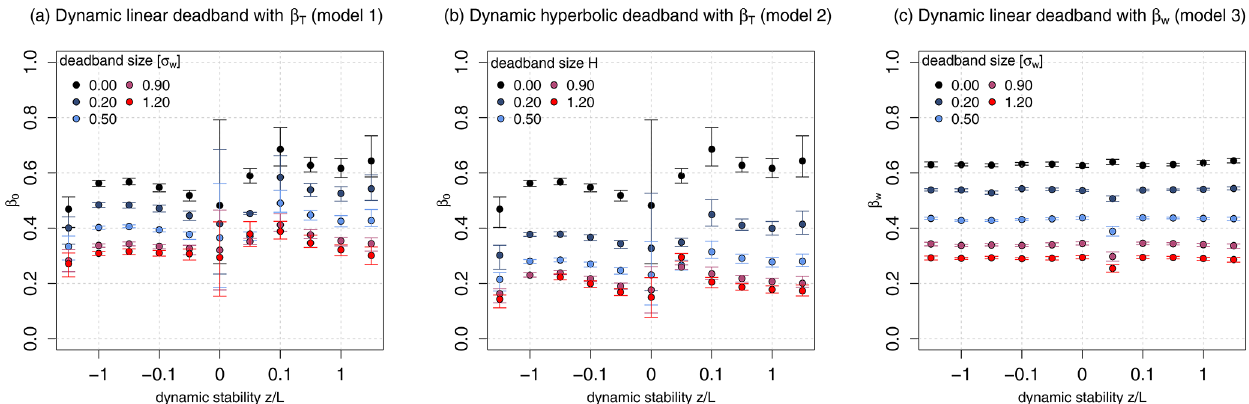
Figure 10. Dependence of the β T and β w factors on the atmospheric stability z/L . Data were binned in logarithmic, evenly spaced stability classes. The markers are drawn at the median β of each bin, and the bars mark the interquartile range (IQR). This figure combines valid data points from all three